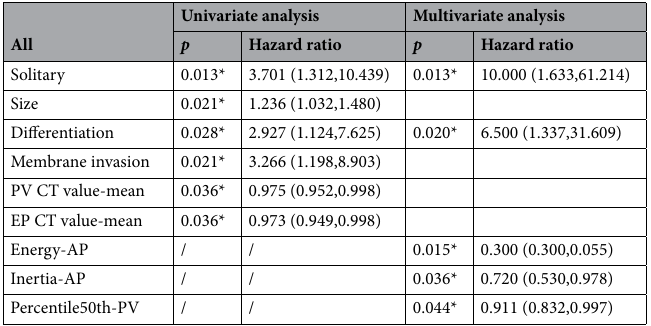
Table 4. Logistic regression analysis for predicting early recurrence of IMCC based on pathological characteristics, preoperative CT features and clinical indicators (Combined model). PV portal venous phase, EP equilibrium phase. * p < 0.05.